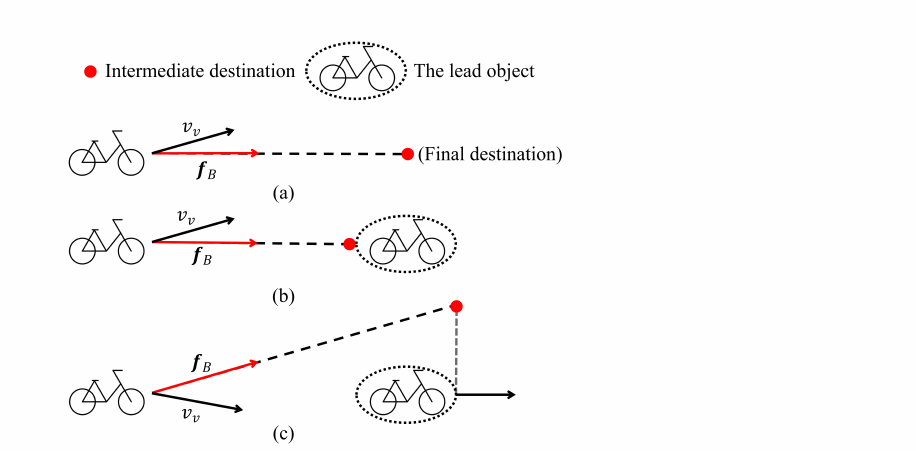
Figure 5. Intermediate destination for free movement, following and overtaking actions. ( a ) Free movement-driving force. ( b ) Following behavior-following force. ( c ) Overtaking